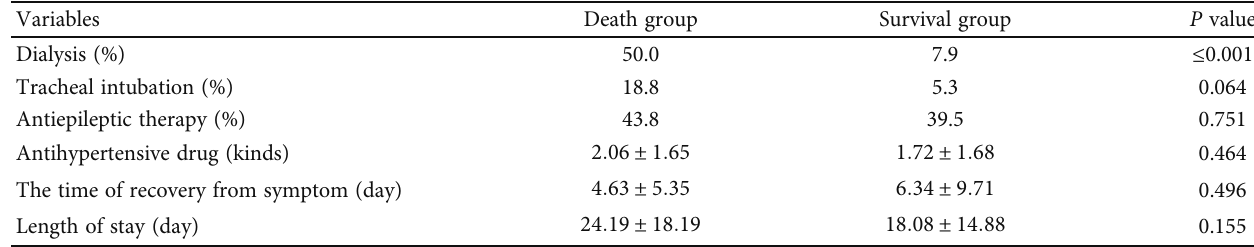
Table 5: Treatment comparison.